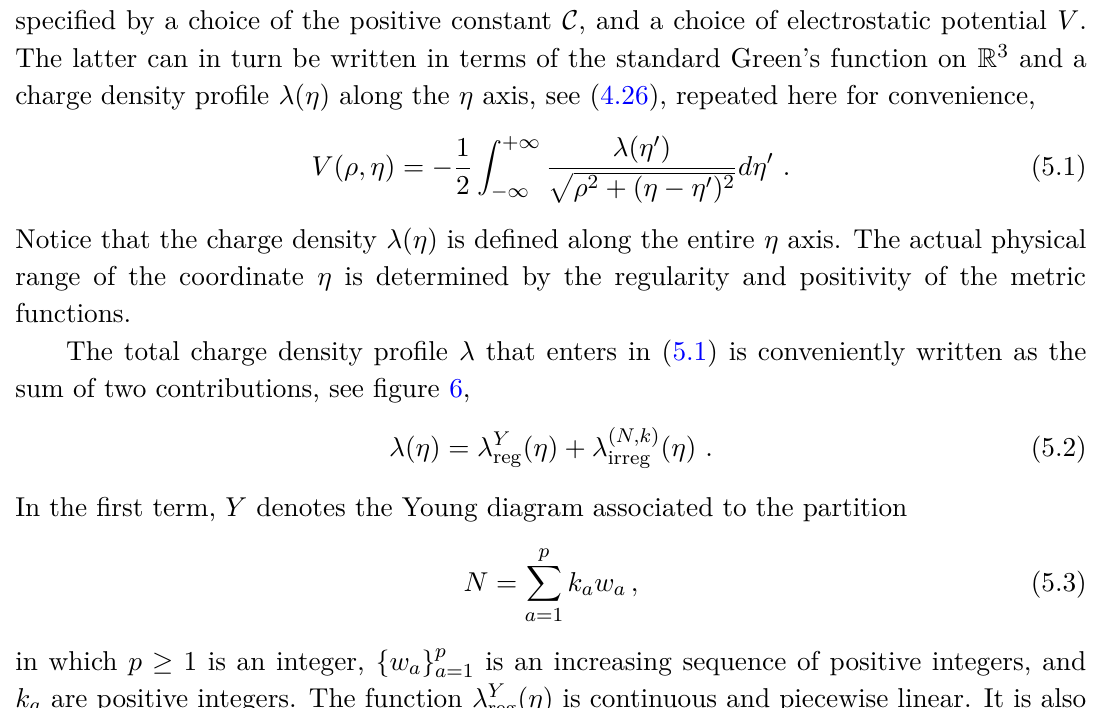
Figure 5. The extended charge density profile λ ( η ) for Case III. We notice the absence of “mirror monopoles”: the charge density outside the interval [ η most segments in a trivial way. The labels P obtained by decorating the extended charge density profiles with additional